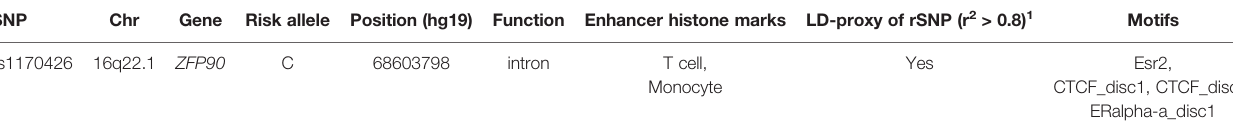
TABLE 2 | Functional annotation of rs1170426. SNP Chr Gene Risk allele Position (hg19) Function Enhancer histone marks LD-proxy of rSNP (r 2 > 0.8)